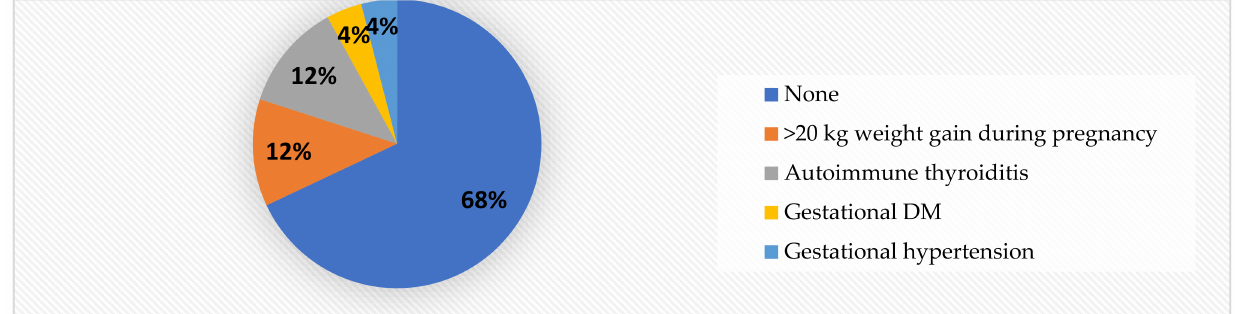
Figure 6. Mother’s health during pregnancy in normal-weight